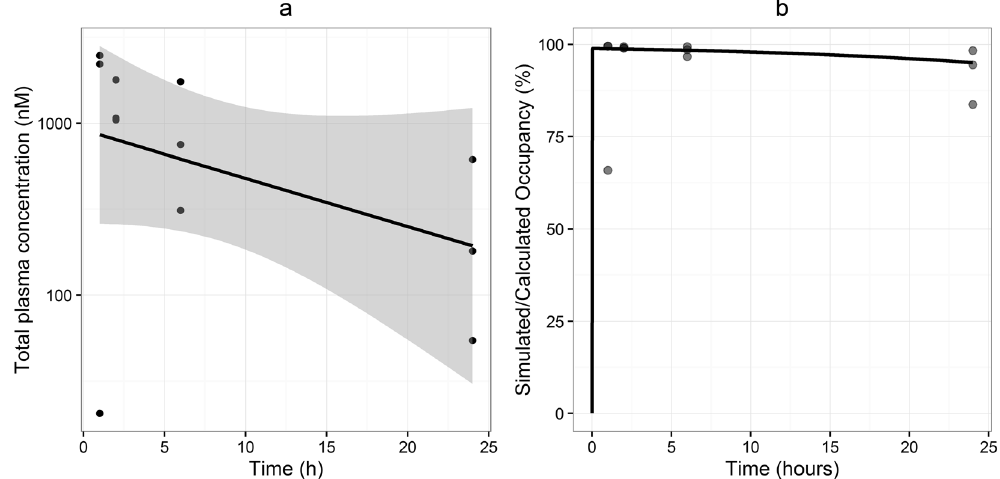
Figure 8. Total plasma concentrations, calculated and simulated target occupancy. ( a ) Observed plasma concentrations (dots), linear fit of the data (line) and 95% confidence interval of the linear regression (shaded area). ( b ) Equilibrium occupancy derived from the experimentally observed plasma concentrations (dots) and simulated occupancy on basis of the observed binding kinetics and plasma elimination rate (line). Graphs shown are representative from one experiment (n = 3 per time